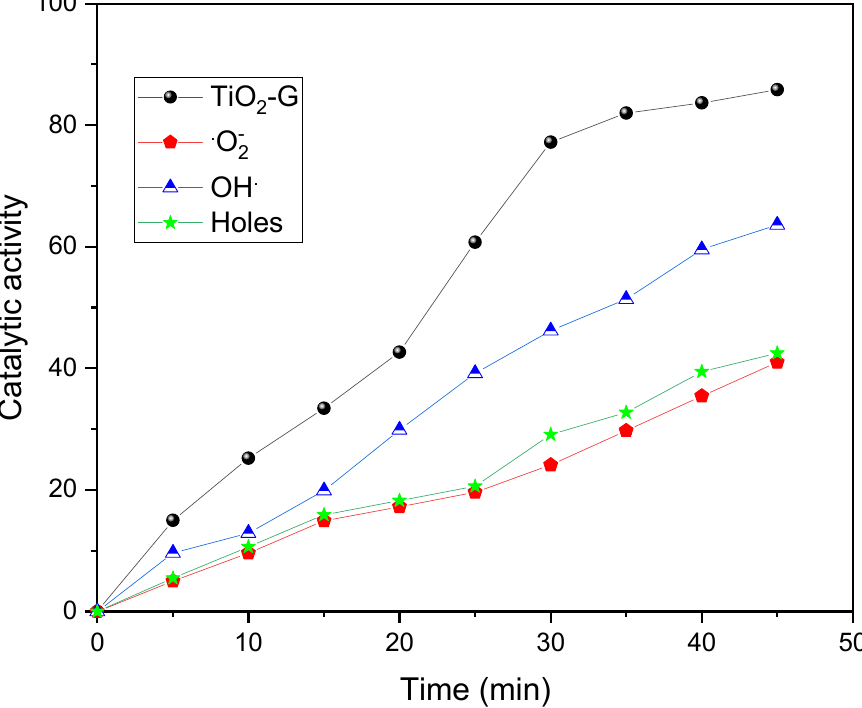
Figure 4. Catalytic activity of TiO 2 -G film electrodes and TiO 2 -G film electrodes with scavengers (1,4-benzoquinone, ethylenediaminetetraacetic acid and tert-butyl alcohol) at optimized operational conditions.